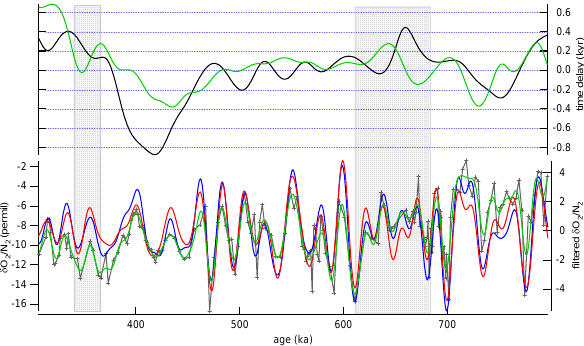
The grey rectangles indicate the periods when the resolution of the δ O 2 /N 2 signal is too low (> 3 kyr), limiting the validity of the filtering.